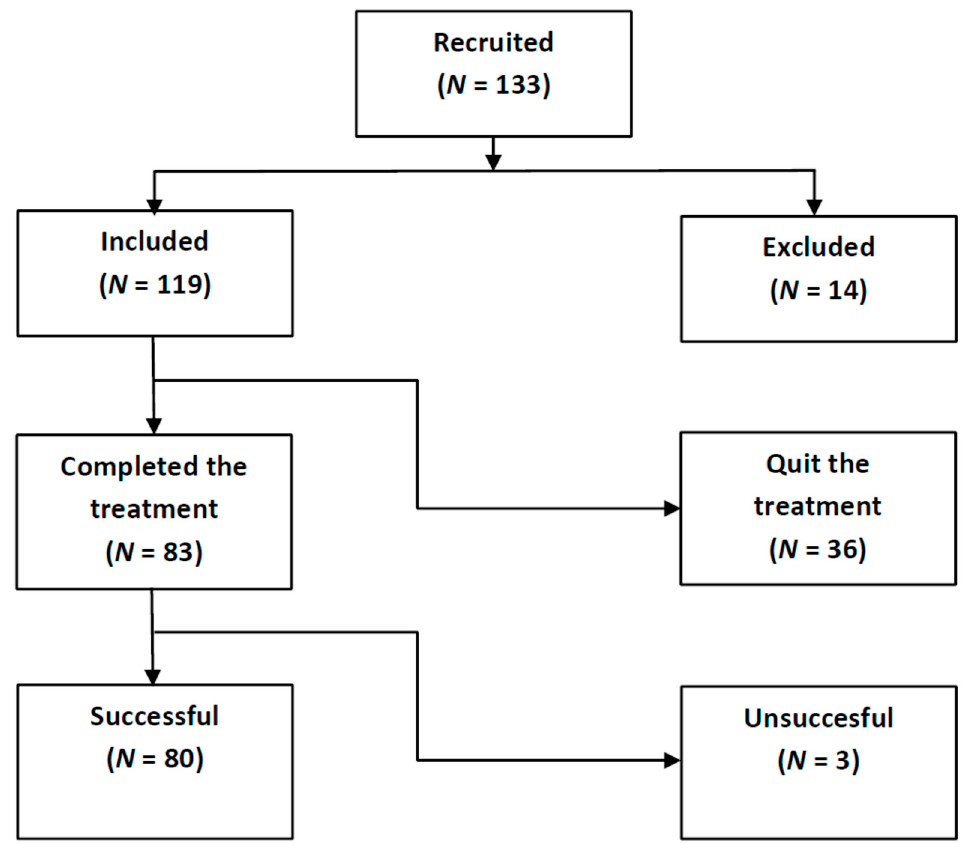
Figure 1. Flow diagram of participant enrollment, intervention and analysis in the current study. Table 1. Baseline characteristics and demographics of patients who completed the treatment.